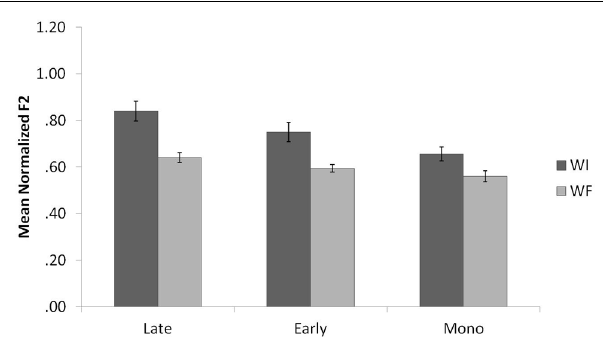
FIGURE 1 | Mean normalized F2 values by context for Late Bilinguals, Early Bilinguals, and Monolinguals for English. Error bars refer to standard errors;WI refers to word-initial, andWF refers to word-final.